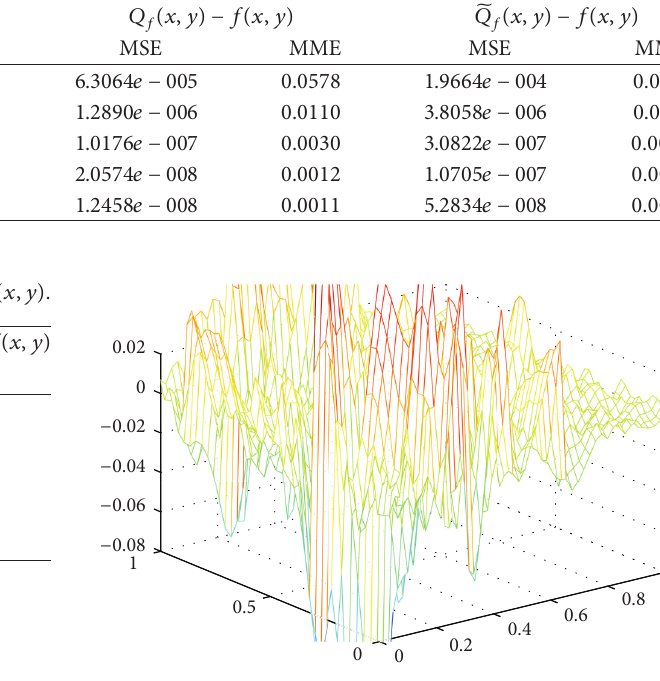
Figure 14: The error graph of Shepard